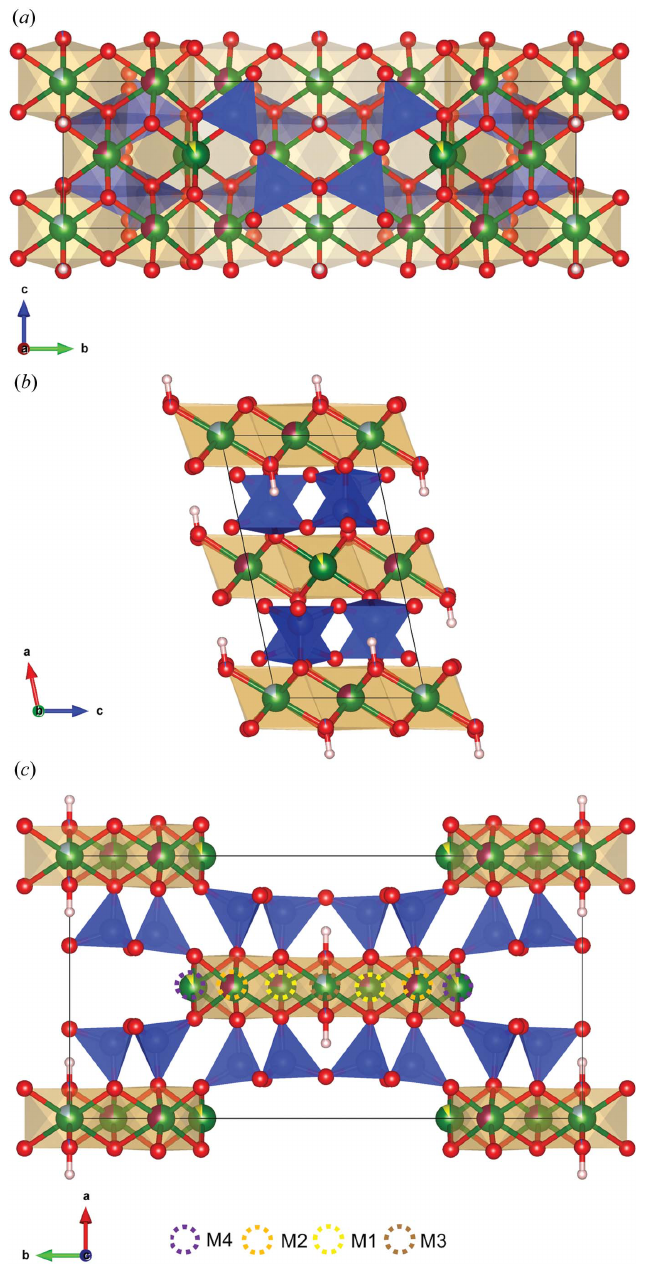
Figure 4 The structure model of fibrous amosite (fibre_T). ( a ) Projection along a , ( b ) projection along b and ( c ) projection along c . Legend: blue polyhedra = tetrahedral centred by Si, blue balls = Si atoms, green balls = F atoms, red balls = O atoms, purple balls = Mg atoms, yellow balls = Ca atoms, light blue balls = F substituting O atoms. The dotted line circles are used to better illustrate the amphibole sites (Hawthorne, 1983). The plots were created using the VESTA software (Momma & Izumi,